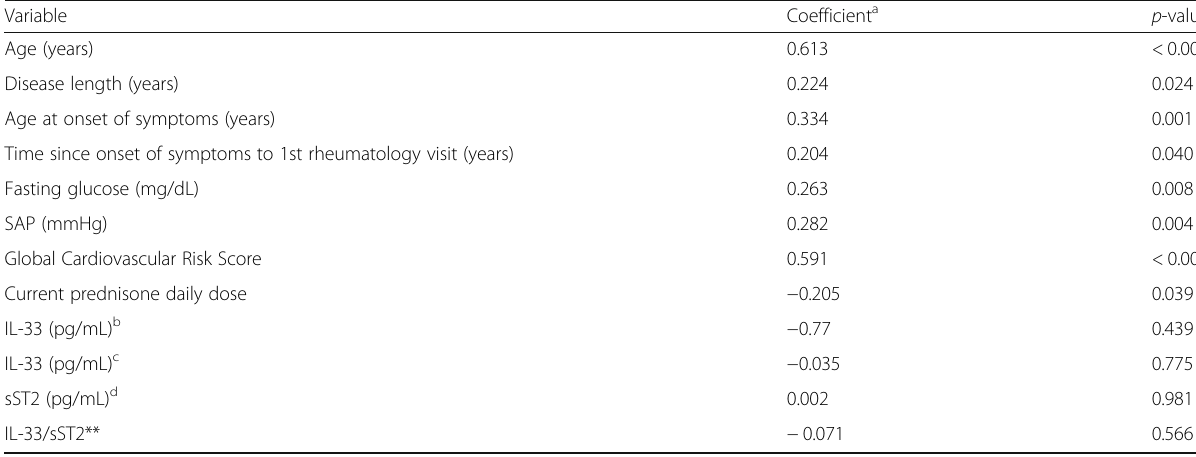
Table 4 Correlation of IMT with clinical and laboratory characteristics Variable Coefficient